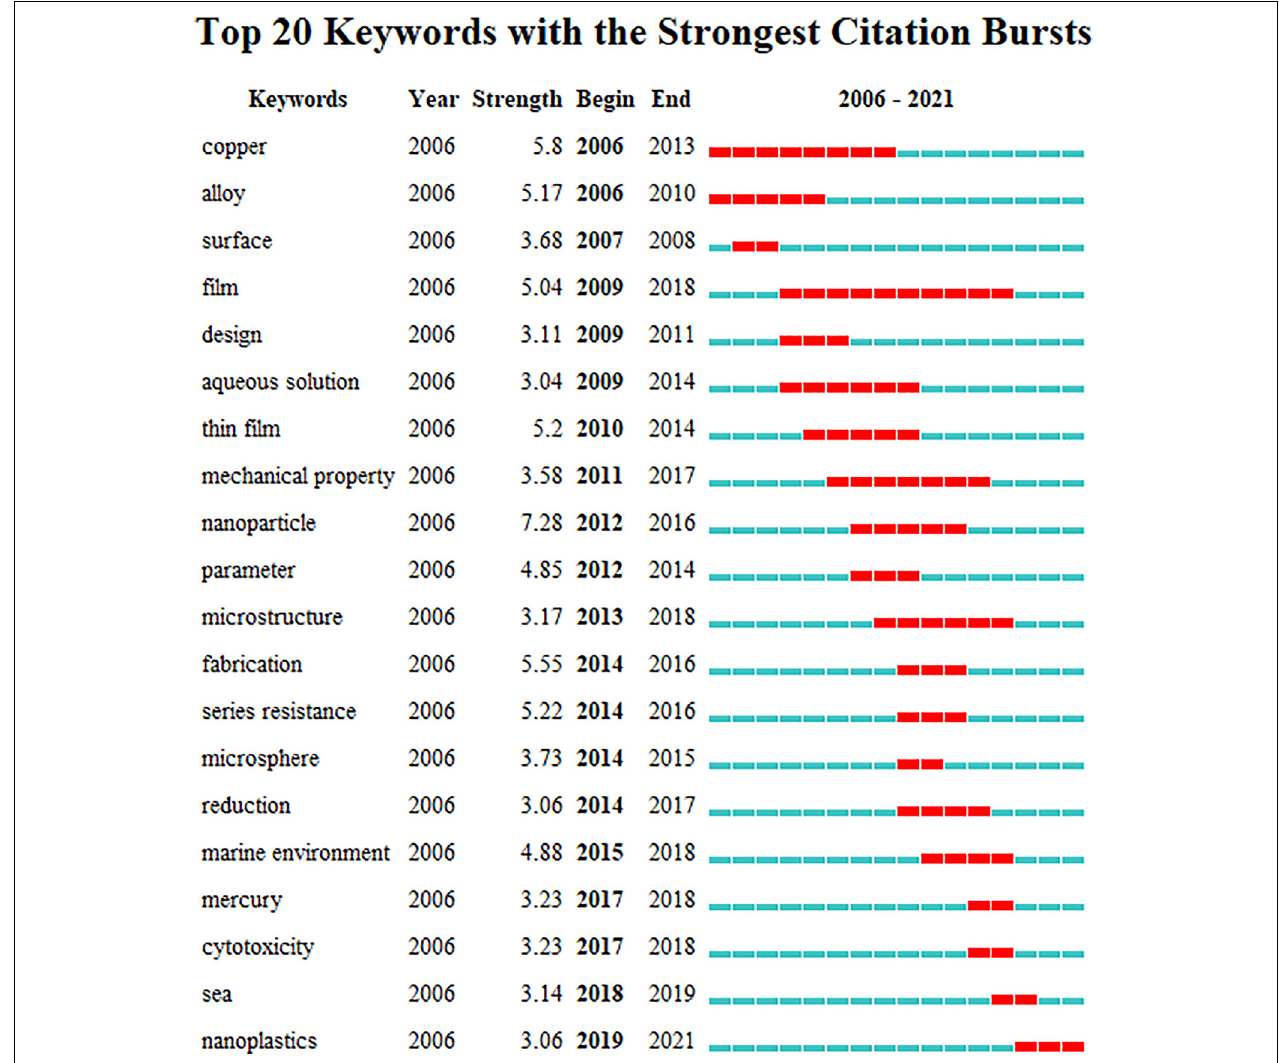
FIGURE 1 | Top 20 keywords with the strongest citation bursts during